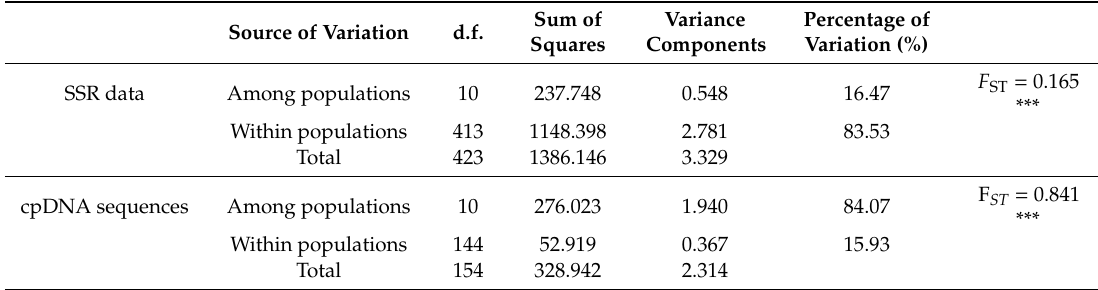
Table 3. Analysis of molecular variance (AMOVA) based on 14 microsatellites and three cpDNA sequences in R. rex subsp. rex. d.f.: degrees of freedom.